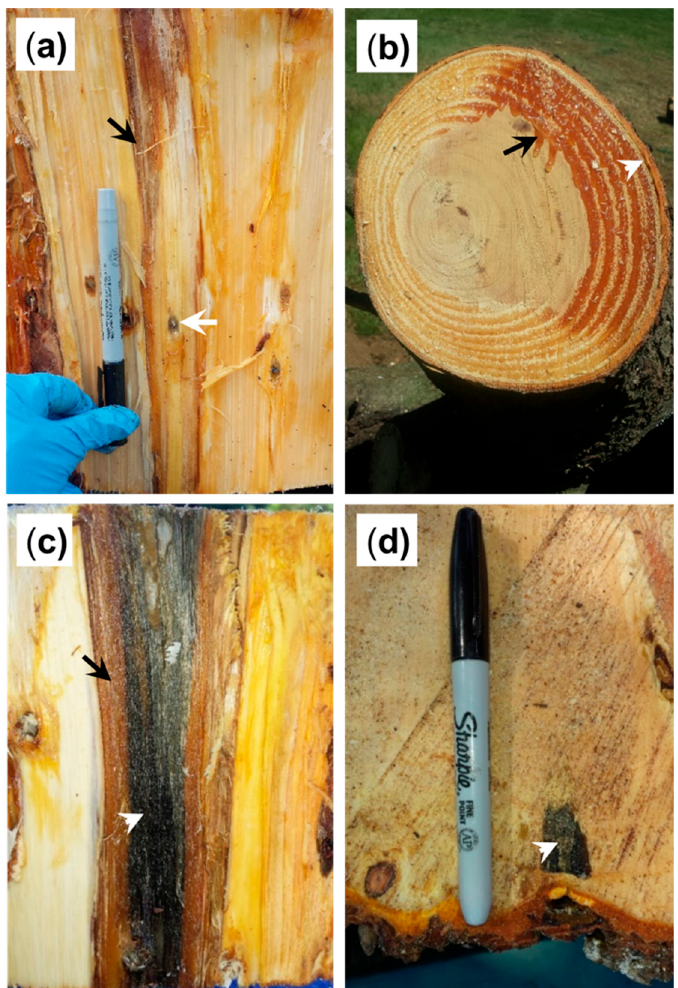
Figure 2. ( a ) Lesion (black arrow) in eastern white pine following inoculation (white arrow) with O. minus after 28 dpi; ( b ) cross-section of a stem of an inoculated tree showing resin produced in sapwood (black arrow) and signs of blue-stain between bark and sapwood (white arrowhead) after 28 dpi; ( c ) blue-stain (white arrowhead) and lesion response (black arrow) developed following inoculation with O. minus after 65 dpi; ( d ) transversal view of an inoculated tree showing blue-stain (white arrowhead) in sapwood after 65 dpi.